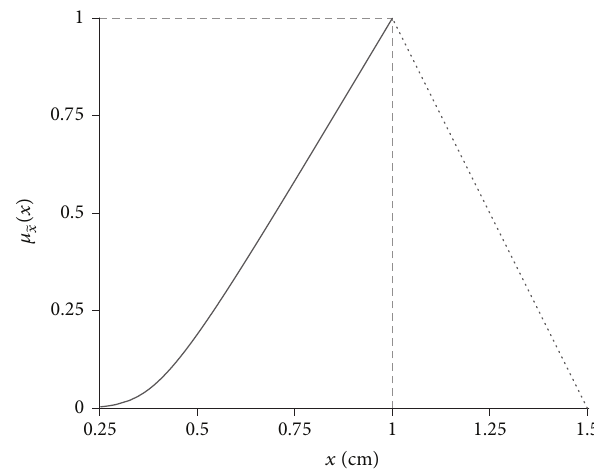
Figure 5: Membership function of ̃𝑥